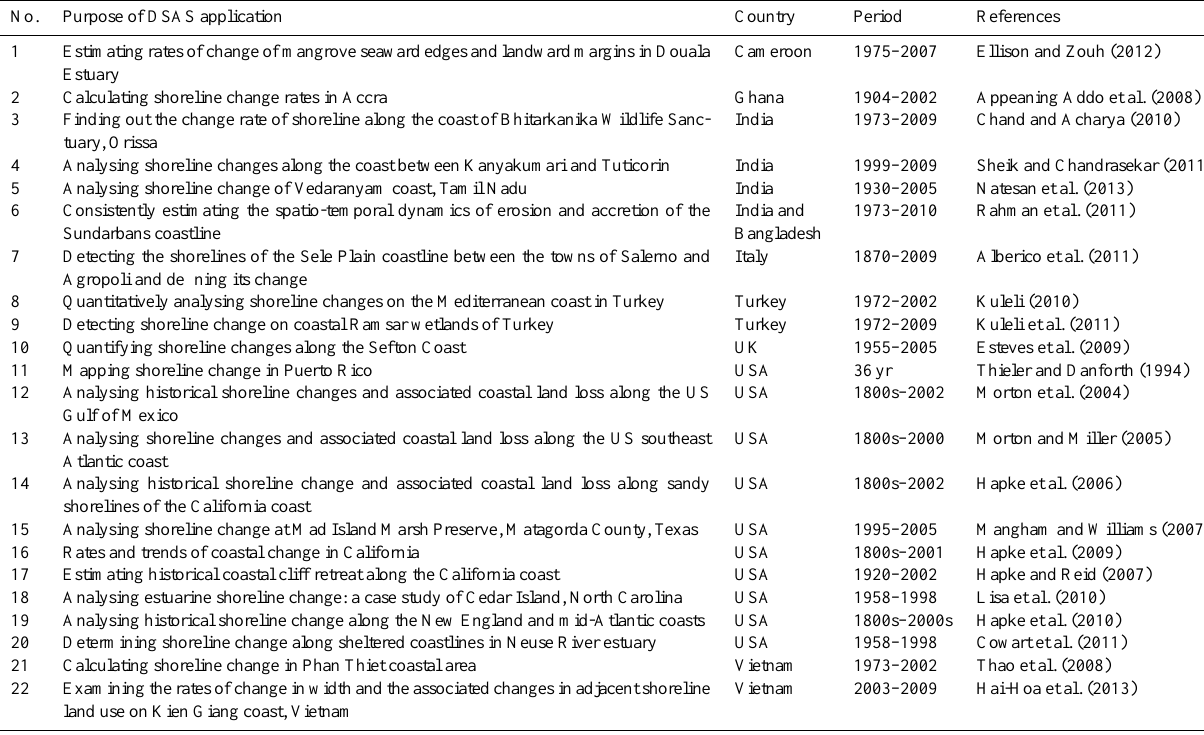
Table 1. History of universal DSAS